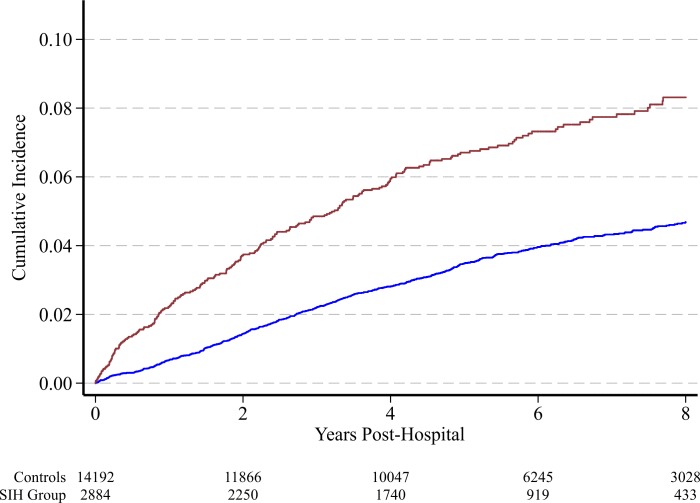
Cumulative incidence for type 2 diabetes for the control group (blue line) versus stress induced hyperglycemia (red line).